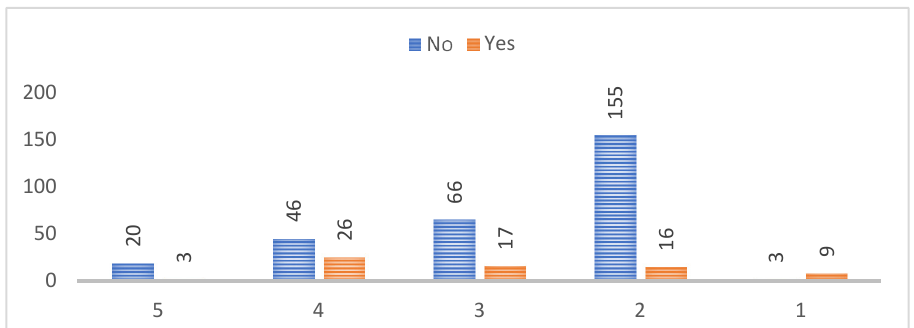
Figure 5. Distribution of respondents’ answers to the question about their experience with assistance in managing a company (yes, no) and intention to start their own business (1, I have my own business; 2, yes, in the next three years; 3, yes, but first I will gain professional experience; 4, I do not reject this option; 5, no). Table 4. Distribution of respondents’ answers within the framework to address the hypothesis that experience with company management has a positive effect on students’ intentions to start their own business. “Are You Going to Start Experience with Your Own Assistance in Managing a Company